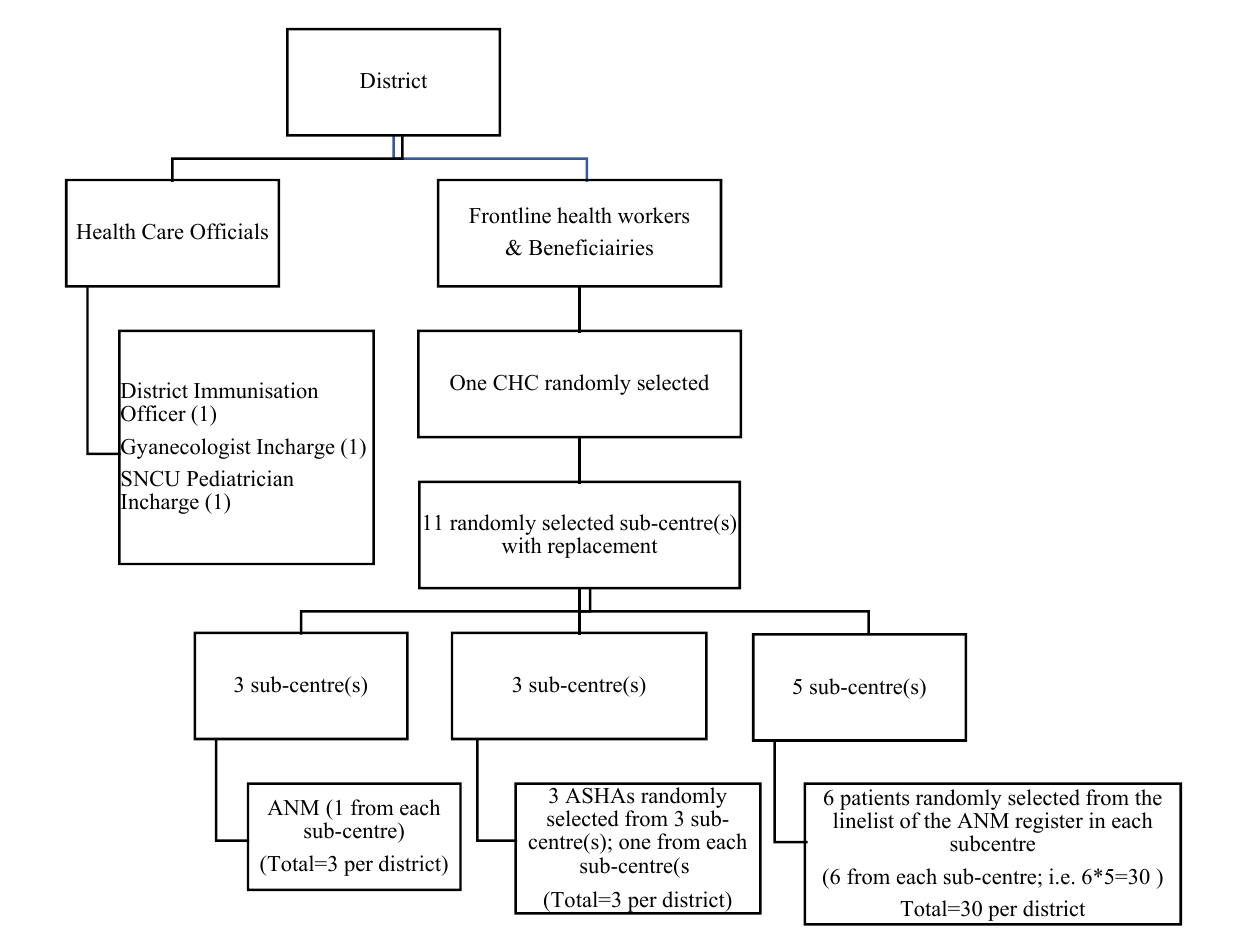
Figure 1. Flow diagram depicting the sampling strategy of HCW and patients for each district.